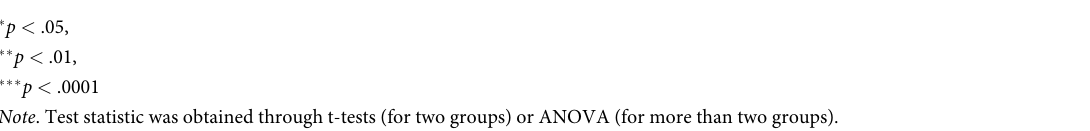
tested positive ( B = 0.28, 95% CI : 0.14, 0.42), completion of double doses of vaccine ( B = -0.66, 95% CI : -0.87, -0.44), optimism ( B = -0.10, 95% CI : -0.13, -0.07), and mindfulness ( B = -0.08, 95% CI : -0.09, -0.07) emerged as significant and independent predictors of anxiety in the fully adjusted model. Among them, mindfulness ( β = -.26), living in Chattogram division ( β = -.26), optimism ( β = -.13), completion of a double dose of vaccine ( β = -.13), and history of mental illness ( β = .11) were the strongest predictors of anxiety. Except for division, the remaining four crucial predictors are